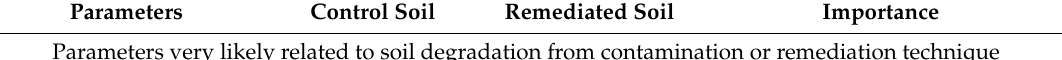
Table 4. Summary and Comparison of Fertility Parameters in Surface Soils (0–30